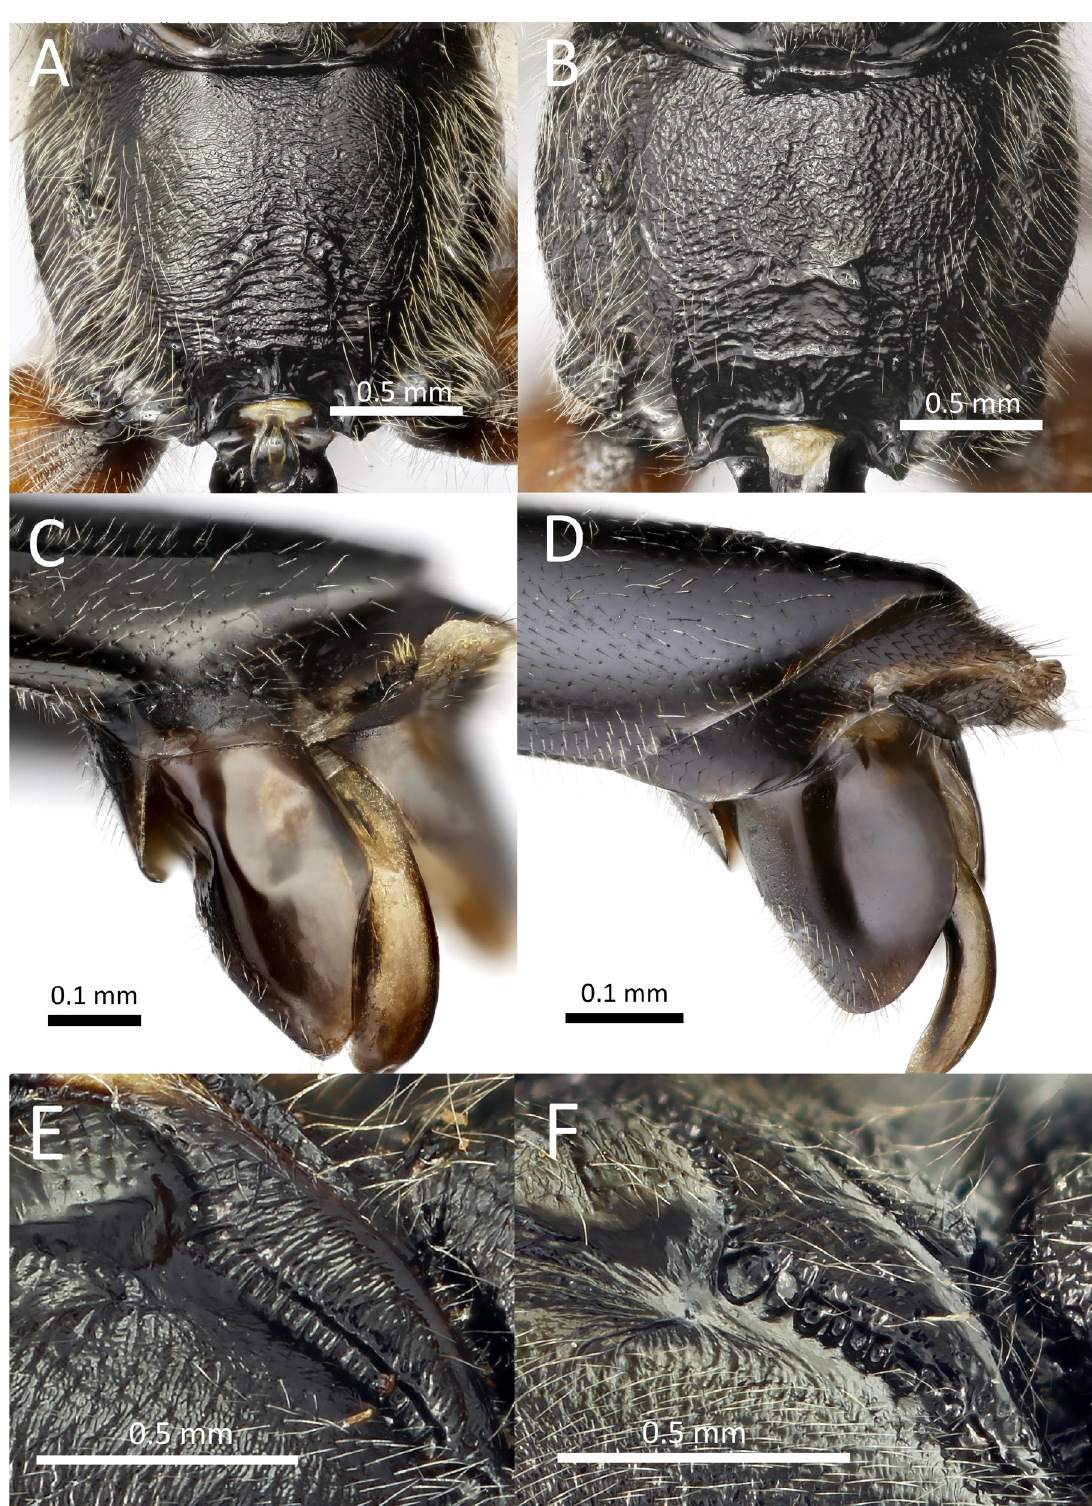
Fig. 6. A . Neoxorides collaris (Gravenhorst, 1829), ♀ (NJ), propodeum, dorsal view. B . N. opacus (Kokujev, 1903) stat. rev., ♀ (NJ), propodeum, dorsal view. C . N. collaris , ♂ (NJ), parameres, lateral view. D . N. opacus , ♂ (NJ), parameres, lateral view. E . N. collaris , ♀ (NJ), mesopleural furrow, lateral view. F . N. opacus , ♀ (NJ), mesopleural furrow, lateral view. Photos: Alexander